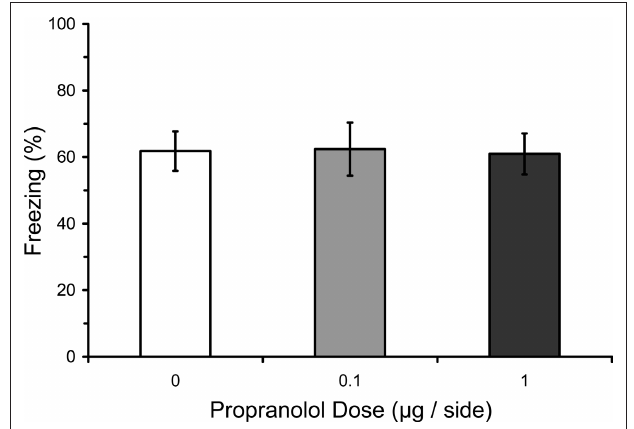
Figure 5 | Pre-training propranolol disrupts within-session fear acquisition. Propranolol pre-treated rats from Experiments 1 and 2 (0 μg, n = 13; 0.1 μg, n = 12; 1 μg, n = 13) showed impaired freezing to the auditory conditioned stimulus (CS) within the fear conditioning session. The figure depicts mean freezing levels during the second and third trials of the three-trial training session. ** indicates significantly lower freezing relative to vehicle ( p =